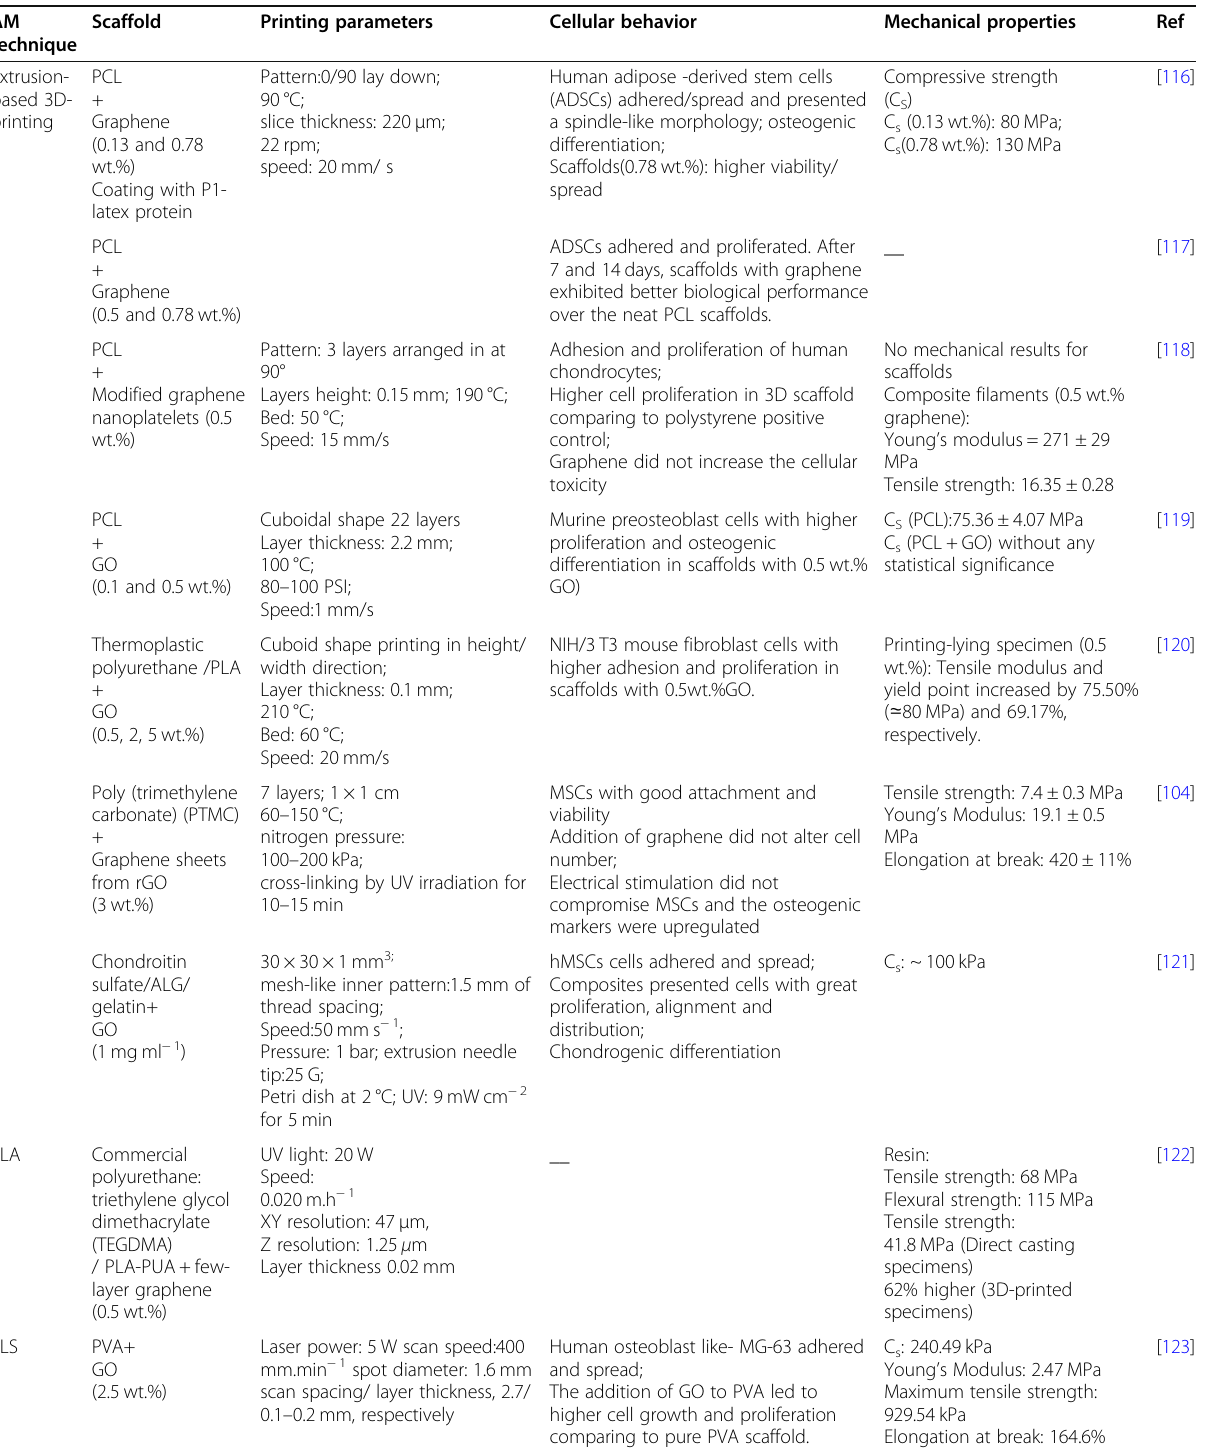
Table 5 Graphene-based 3D-printed scaffolds AM technique